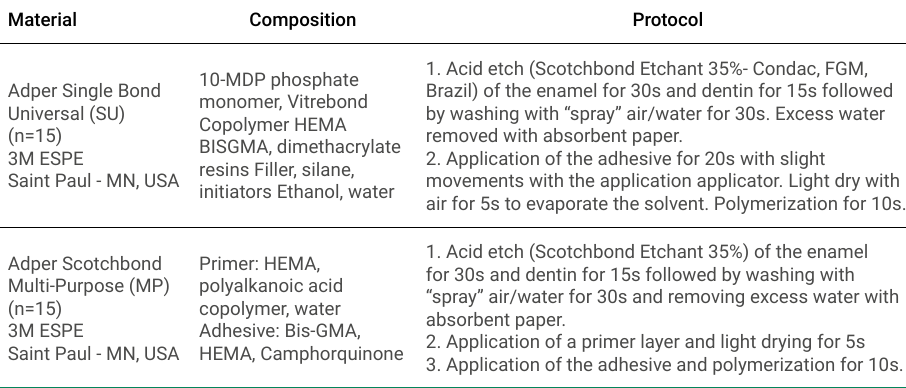
Table 1. Adhesive systems: composition and